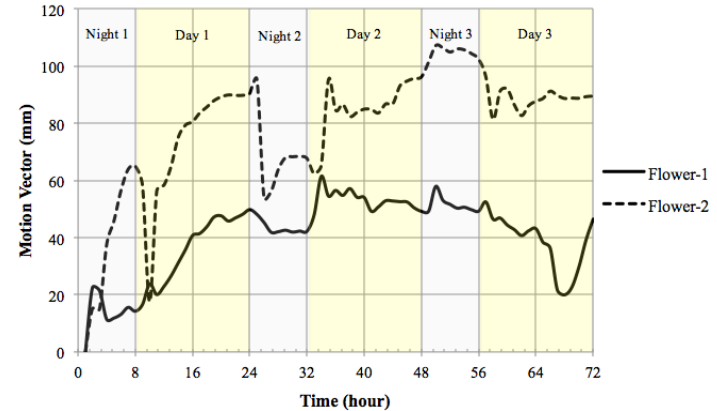
Figure 14. Floral motion vector in